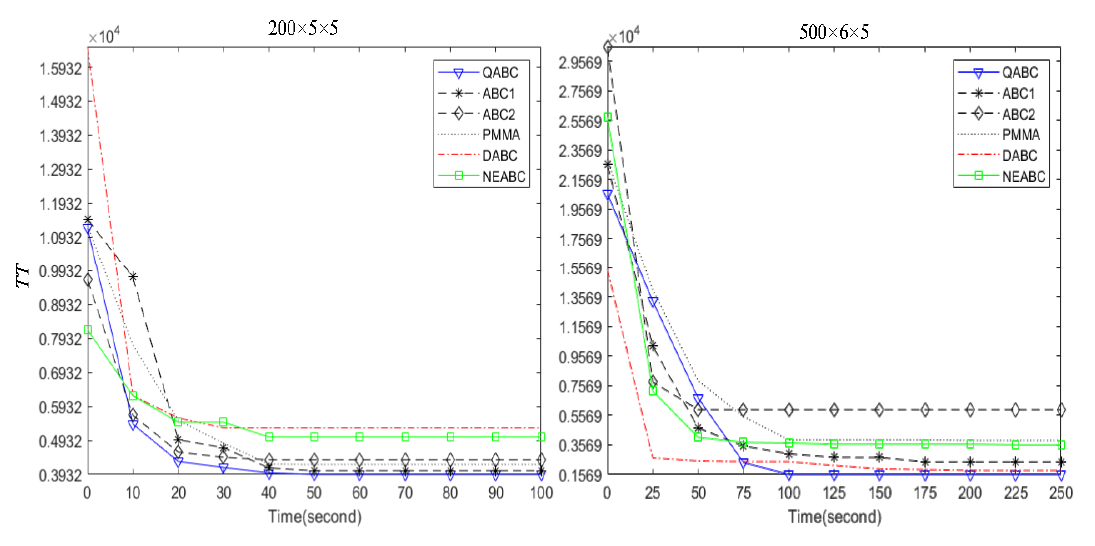
Figure 12. Convergence curves of two